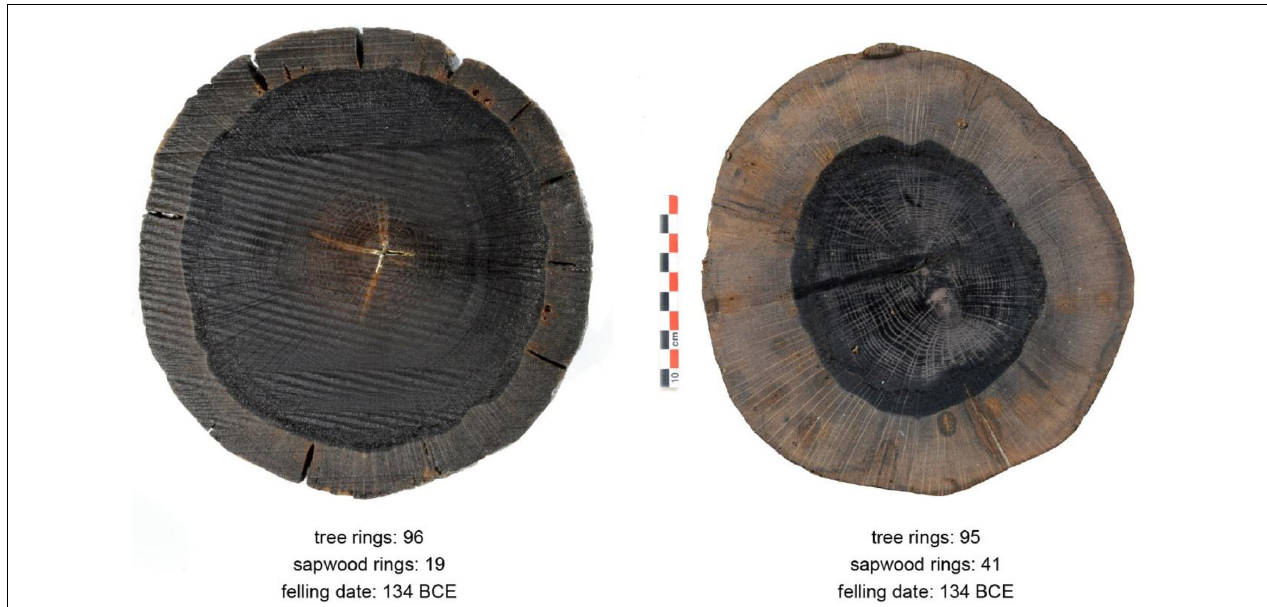
FIGURE 8 | Stem disks of two oak piles from a late Iron Age bridge (Pont-sur-Seine, France) with heart wood, sapwood and waney edge (Leroux et al.,